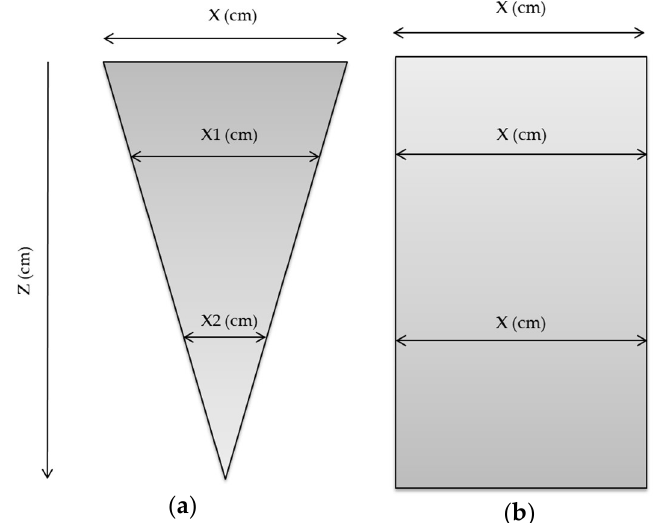
Figure 2. Coverage area for the ( a ) focused traditional DAS technique and ( b ) plane wave (without a focal point).